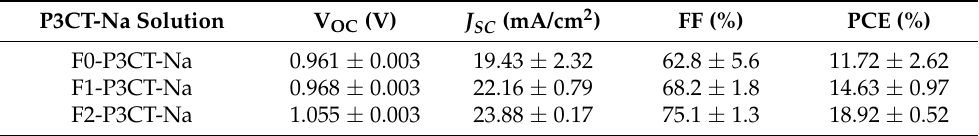
Figure 2. J-V curves of the P3CT-Na based MAPbI 3 solar cells with the different filtering processes under one sun illumination (AM 1.5G, 100 mW/cm 2 ). Table 1. Photovoltaic performance of the P3CT-Na based MAPbI 3 solar cells with the different filtering processes under one sun illumination (AM 1.5G, 100 mW/cm 2 ).